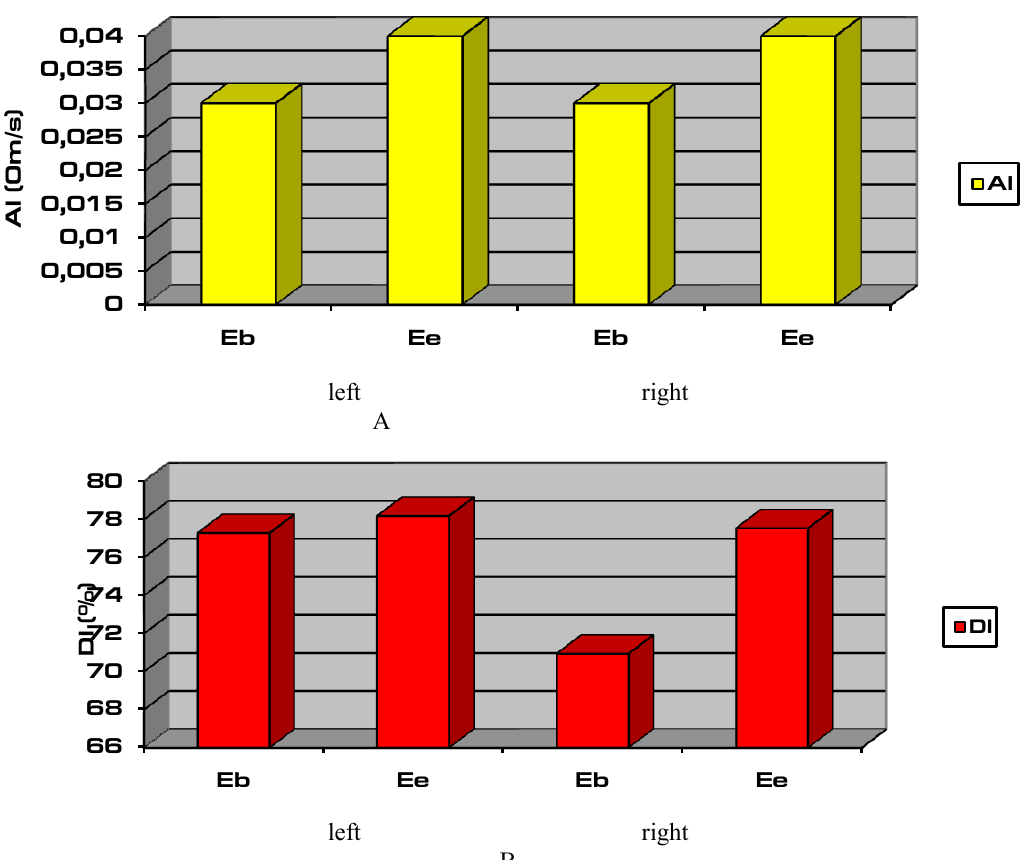
Figure 3. Indexes of peripheral vascular resistance in area of shallow arteries of cerebrum with athletes (heavy athletics) before and after paravertebral miorelaxation (A - amplitude (absolute) indexes, B - amplitude (relative)): AI - amplitude of low wave; DI – dikrotic index; Eb - beginning of experiment; Ee - end of